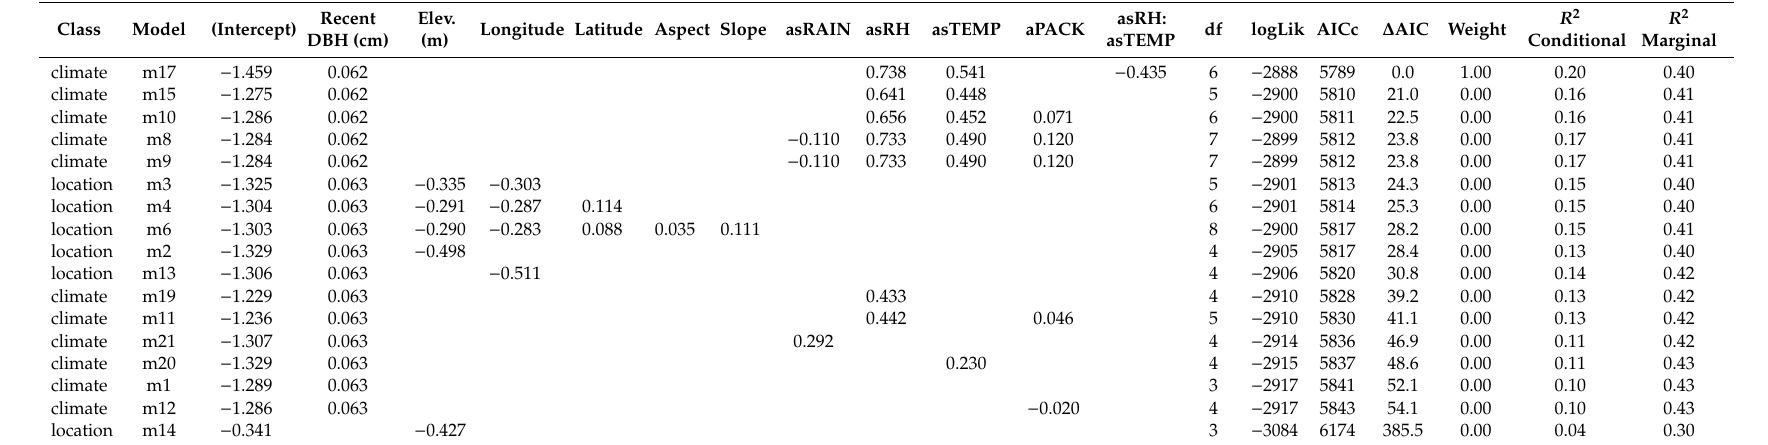
Table 1. Delta AIC ( ∆ AIC) and adjusted R 2 for models of white pine blister rust infection of whitebark pine trees in the Greater Yellowstone Ecosystem. All models included a random intercept for transect. The marginal R 2 is the proportion of variance explained by the fixed factors (climate or location variables), while the conditional R 2 is the proportion of variance explained by both fixed (climate variables or location variables) and random (transect)